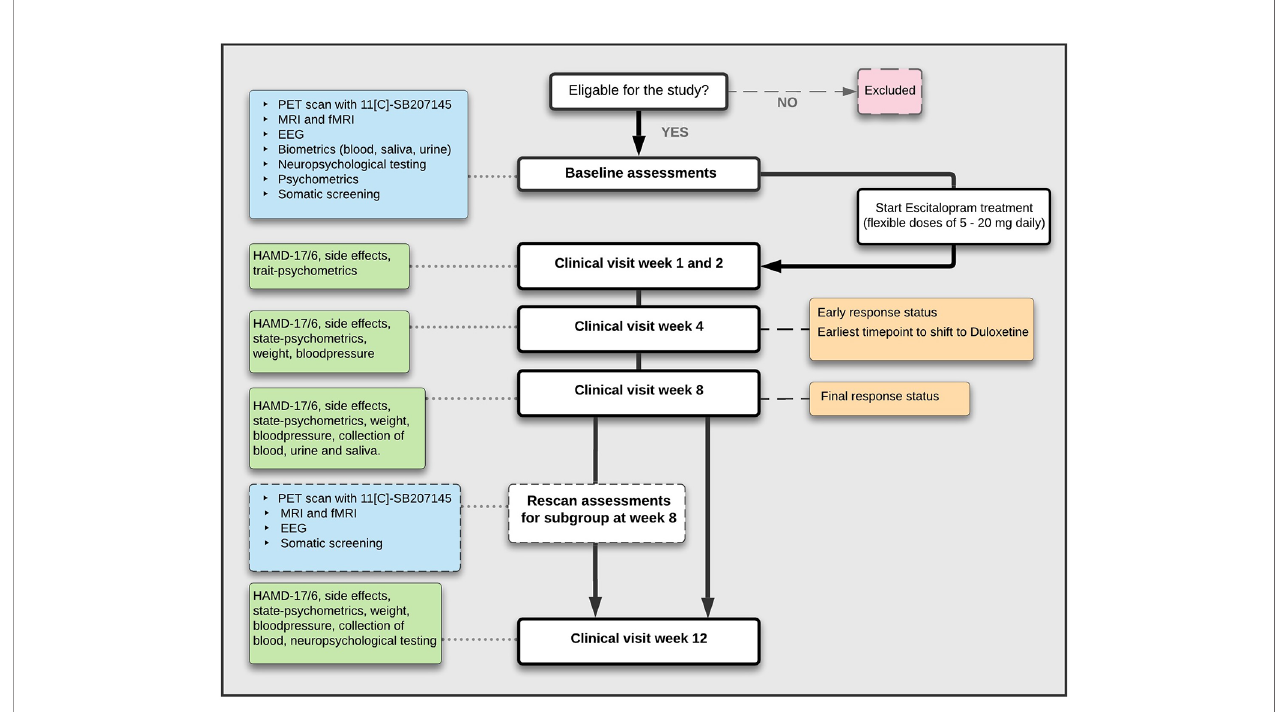
FIGURE 1 | Flowchart of study trial assessments for patients with